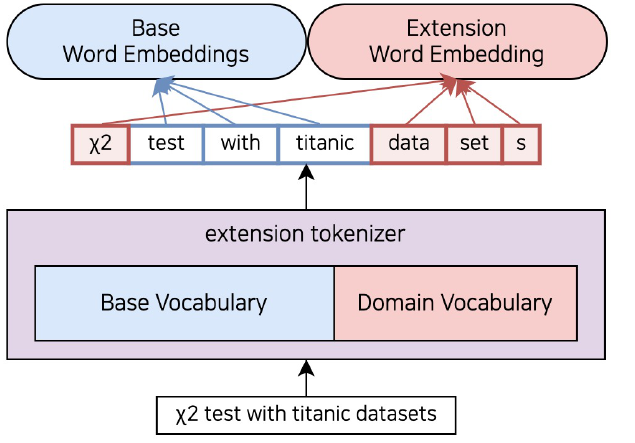
Figure 3. Examples using a tokenizer with a domain-specific vocabulary. The input sentence is tokenized as vocabulary, and domain-specific vocabulary is learned in the pre-training. The extended vocabulary uses the extended embedding added to the existing pre-trained language models embeddings. For example, in the “ X 2 test with titanic datasets” sentence, x 2 , a token as ’[UNK]’ through the existing pre-trained tokenizer, is a token to be ‘ x 2 ’. In addition, “Datasets” can be divided into ‘data’, ‘set’, and